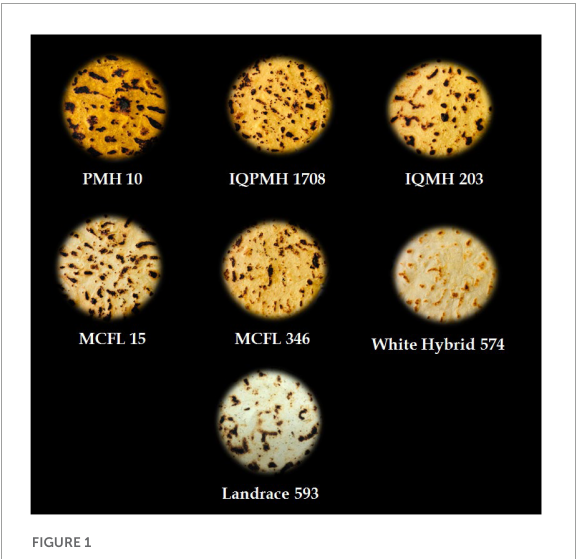
FIGURE1 Chapattis prepared from different